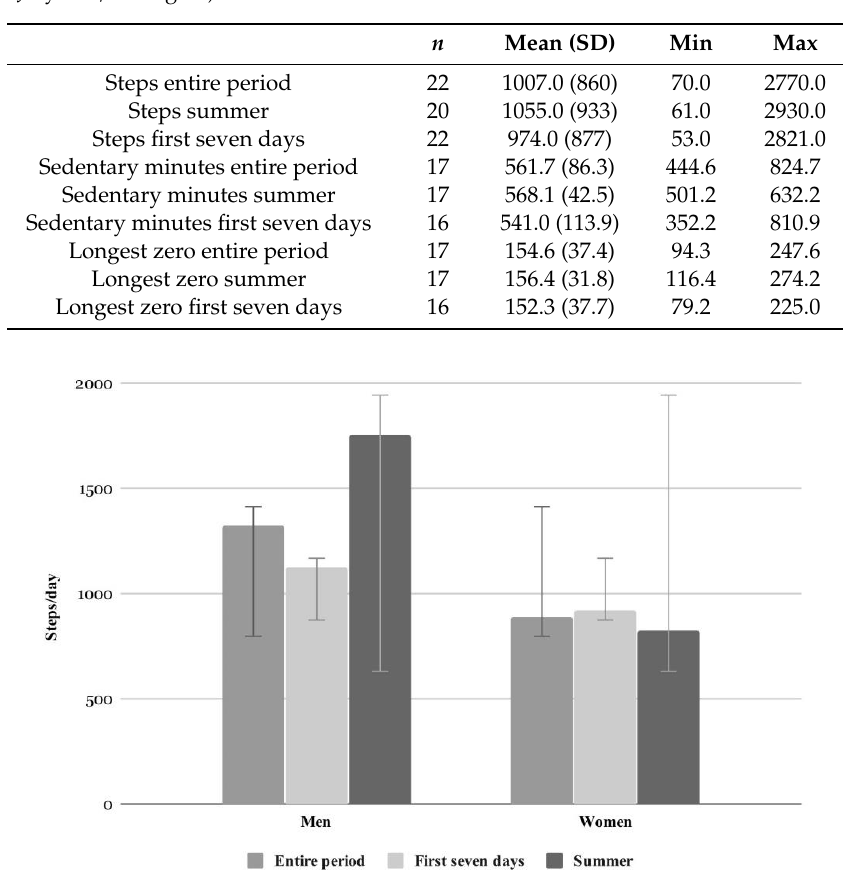
Table 2. Daily physical activity (PA) of the entire period, first seven days, and during summer (two weeks in July and / or August).